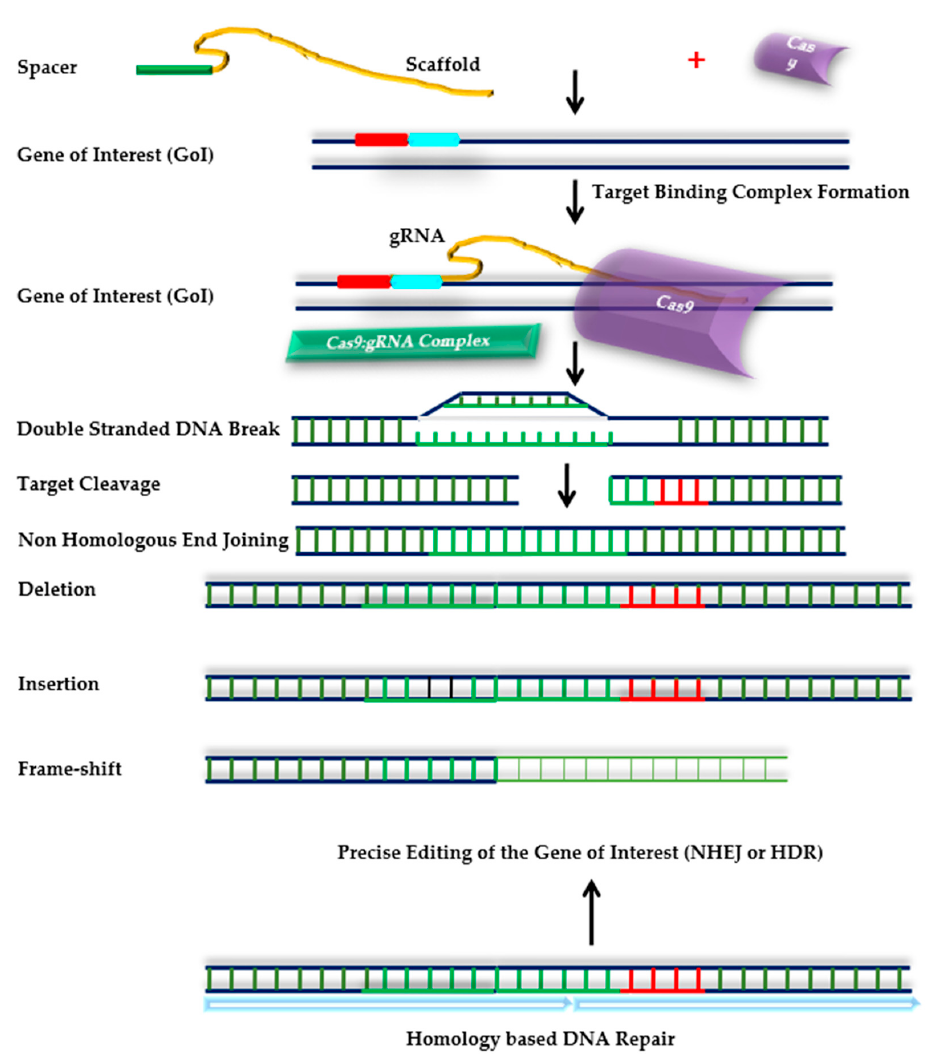
Figure 4. Flow chart of Crispr-Cas9 homology based precise genome/DNA editing for developing HS resilient wheat cultivars.